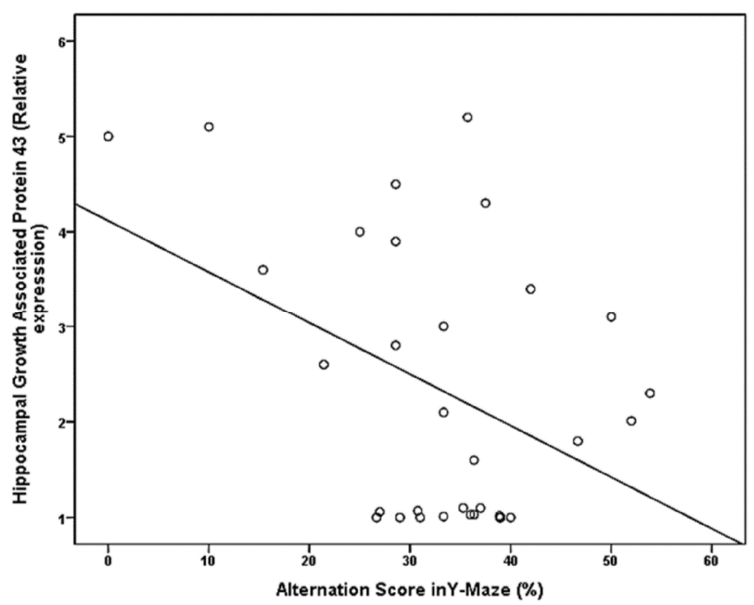
Figure 2. Significant negative correlation between the alternation score and Hippocampal Growth Associated Protein 43 expression.